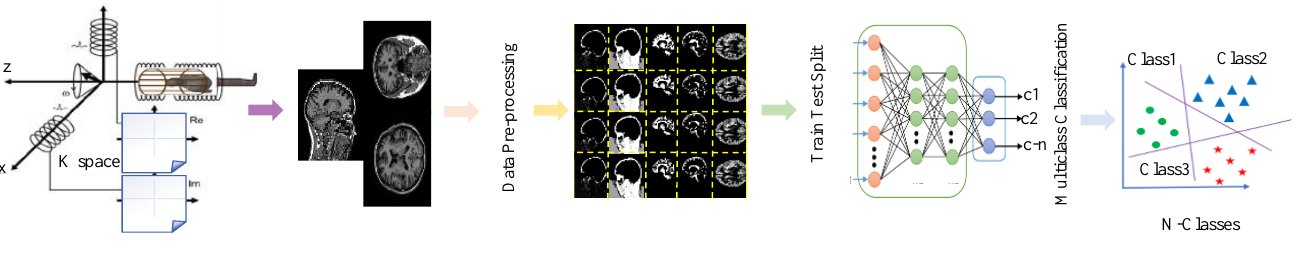
Figure 1. The workflow of the proposed architecture. MRI scans are pre-processed with data cleaning operations for the train-test split to feed in the network for multiclass